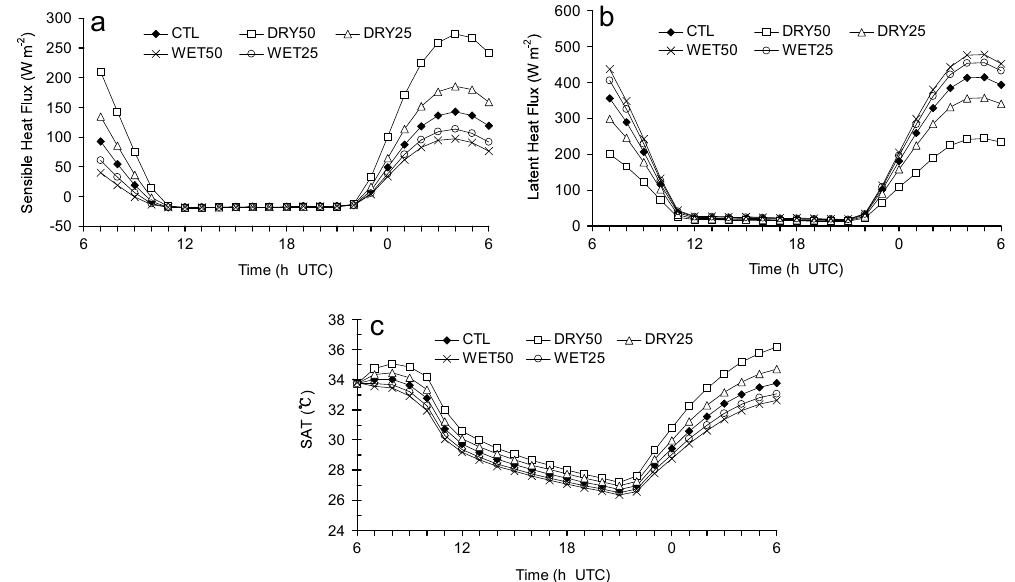
Figure 9. The mean hourly variations in the area-averaged (area D3) surface quantities for the five groups of simulations during 20– 29 July 2003, where the initial flux values are zero (not shown) and the initial temperatures are the same value: (a) sensible heat flux, (b) latent heat flux, (c) SAT.